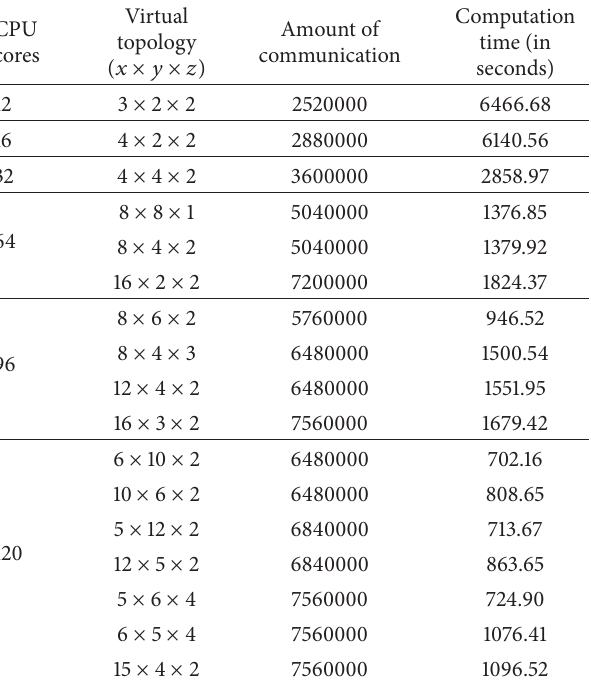
Table 2: Comparisons of virtual topology, amount of communica- tion, and computation time on